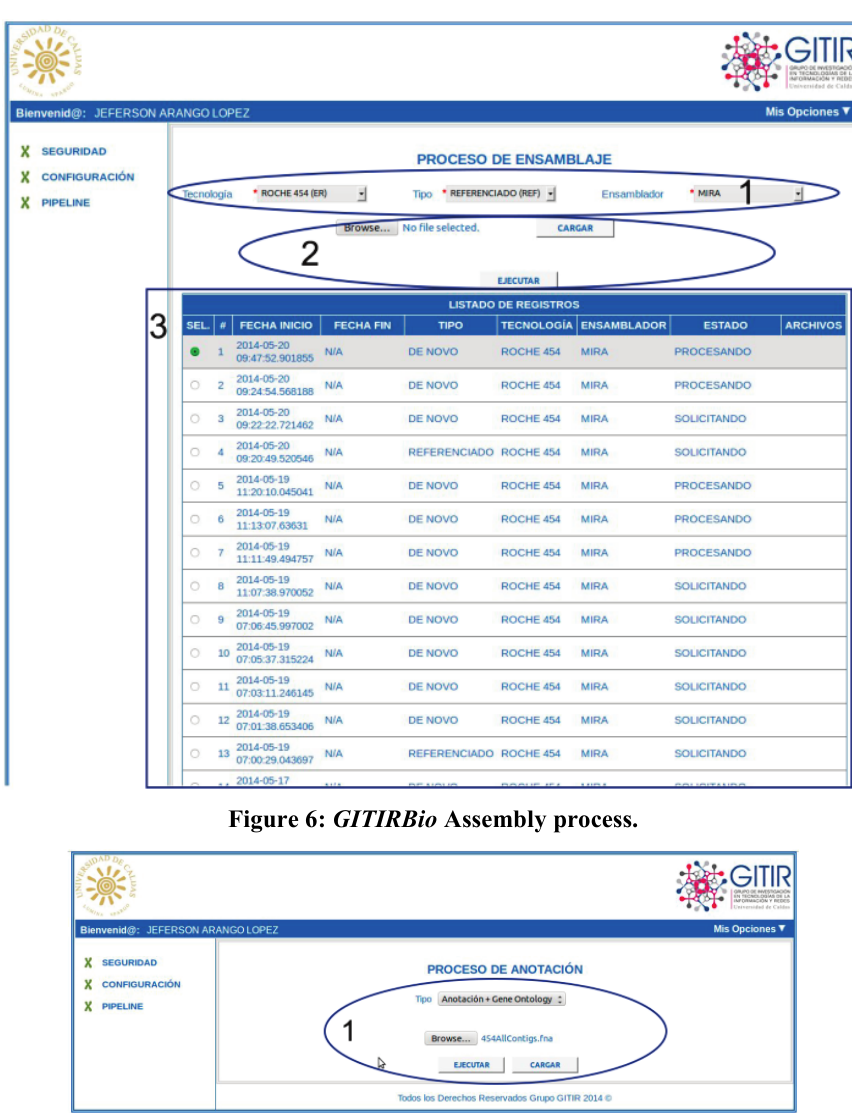
Figure 7: GITIRBio Annotation via Gene Ontology